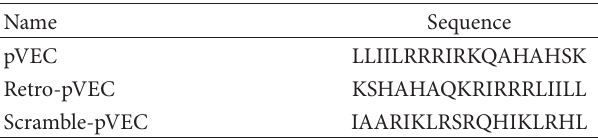
Table 1: The pVEC sequences used in the simulations and the mutated residue for each